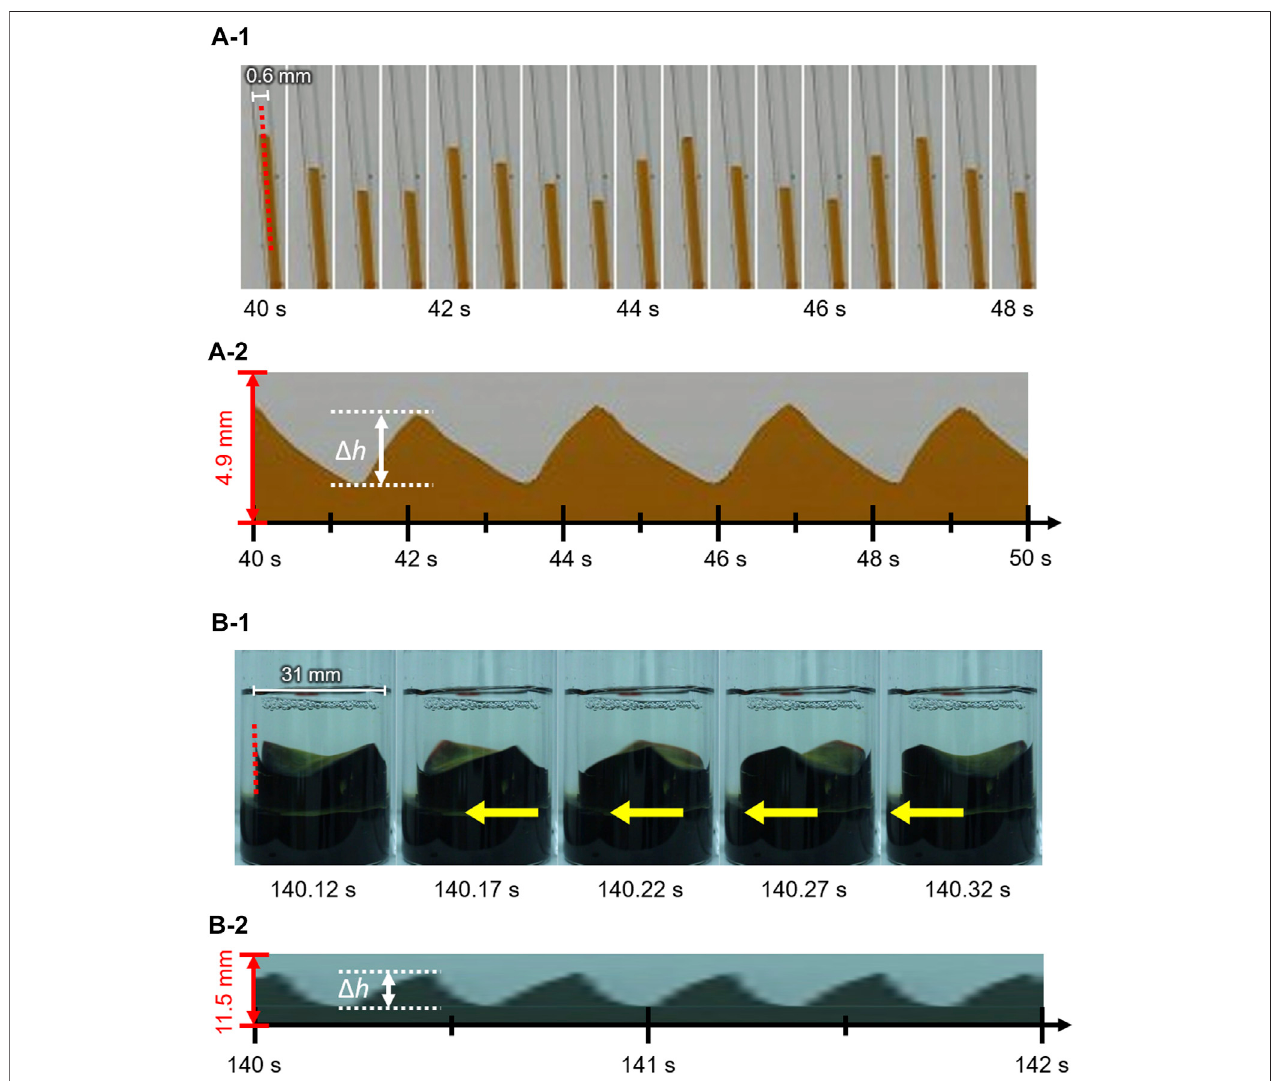
FIGURE2| Snapshotsandspace – timeplotsofoil/watercontactlinemotionsinanopentubewithaninnerdiameterof (A) 0.6 mmand (B) 31 mm.Thecontactline of (A) and (B) exhibits up-and-down motion and traveling-wave motion, respectively.